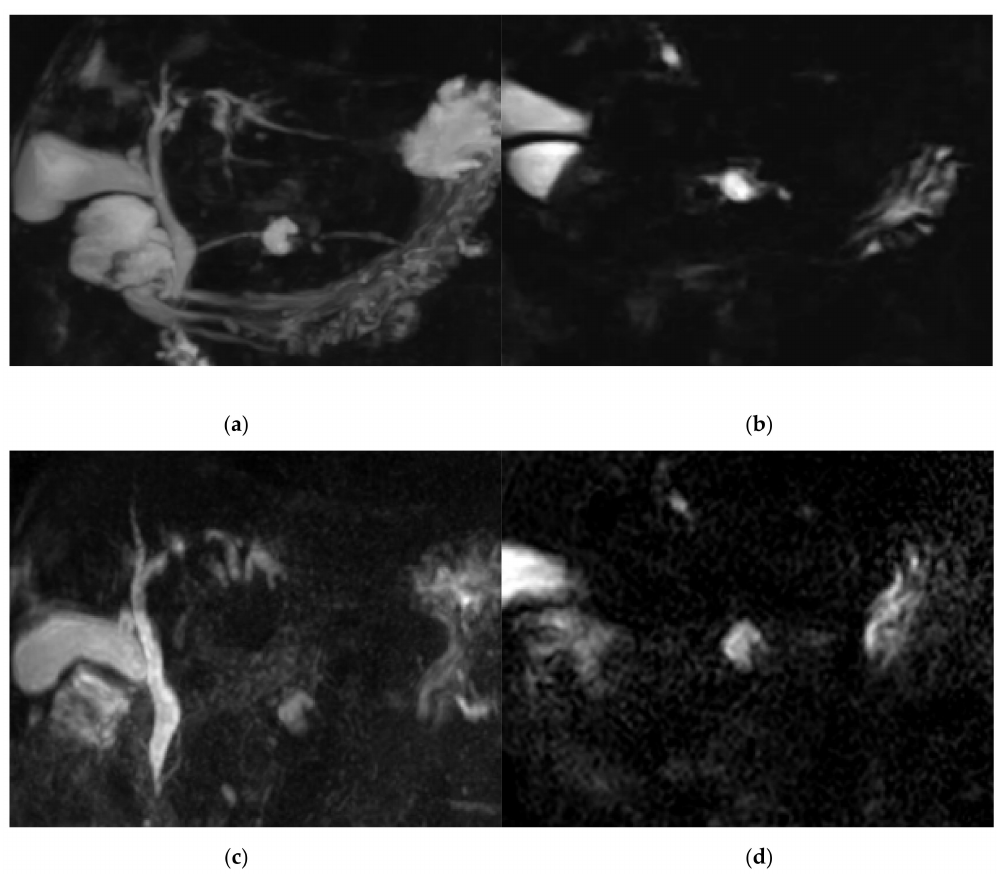
Figure 4. A 79-year-old female with BD-IPMN in pancreatic body. Communication between a cyst and proximal pancreatic duct (PD) was shown with BH-CS-MRCP in both the 3D ( a ) and source image ( b ), but not shown with BH-GRASE-MRCP in both the 3D ( c ) and source ( d ) image. Visualization of proximal PD (5 vs. 5, BH-CS-MRCP vs. BH-GRASE-MRCP, respectively), mid PD (4 vs. 1.7), and distal PD (4 vs. 1.7) were better with BH-CS-MRCP ( a ) than those with BH-GRASE- MRCP ( c